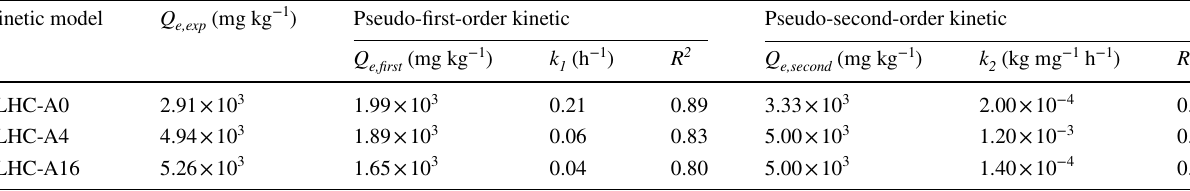
K F is the Freundlich equation constant